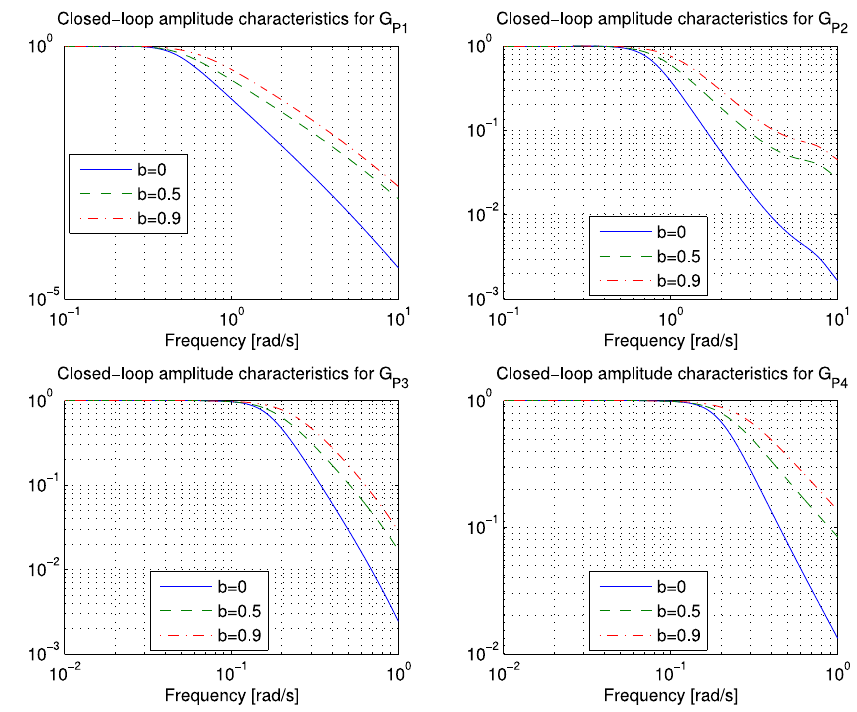
Figure 12. Closed-loop amplitude responses for all four tested processes.